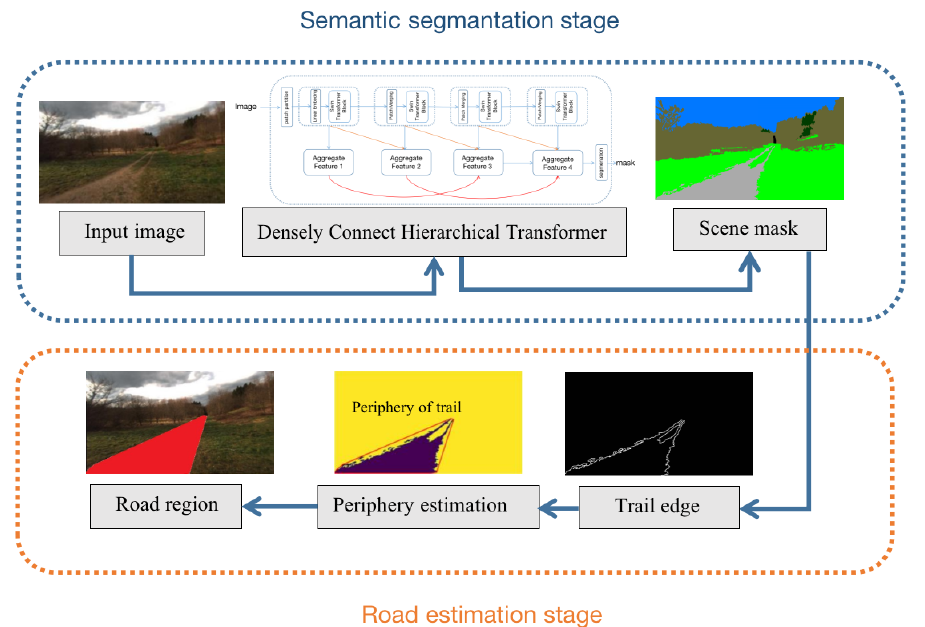
Figure 2. The pipeline of our ARDformer. In the semantic segmentation stage, the scene mask is extracted by a densely connect hierarchical Transformer. In the road estimation stage, the road region is detected based on the periphery information of the trails.